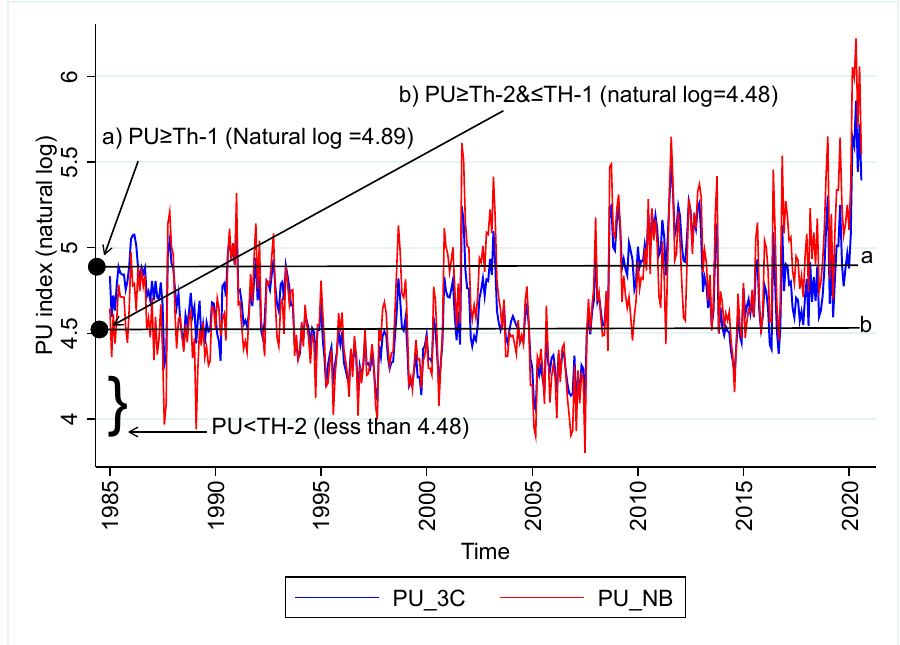
Figure 5. Illustration of identified thresholds (PU). Source: Baker, Bloom, and Davis [12].